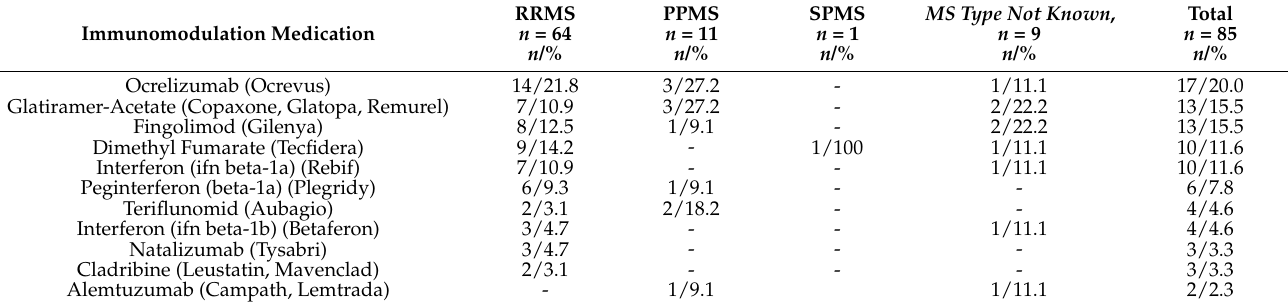
Table 2. Percentages of different immunomodulation drugs used by the participants (N = 85). Immunomodulation